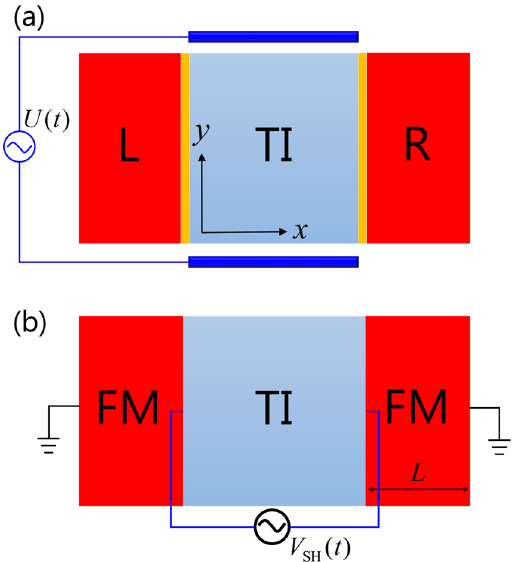
Figure 1. A schematic view of a proposed setup to study the topological ac QSH effect. ( a ) A 2D QSH material is placed between two conductive plates (blue). When an ac electrical voltage U ( t ) is applied across the plates, an electric field E ( t ) will be generated in the y direction. In response, an ac Hall spin current j s ( t ) is created along the x direction. The QSH material is attached with the left and right metallic electrodes (red), with potential barriers (yellow) in between. ( b ) When ferromagnetic metals with length L are used as the electrodes, an ac electric voltage difference V SH ( t ) can be induced between the inside edges of the two electrodes, suggesting a possible experimental way to detect the ac QSH effect